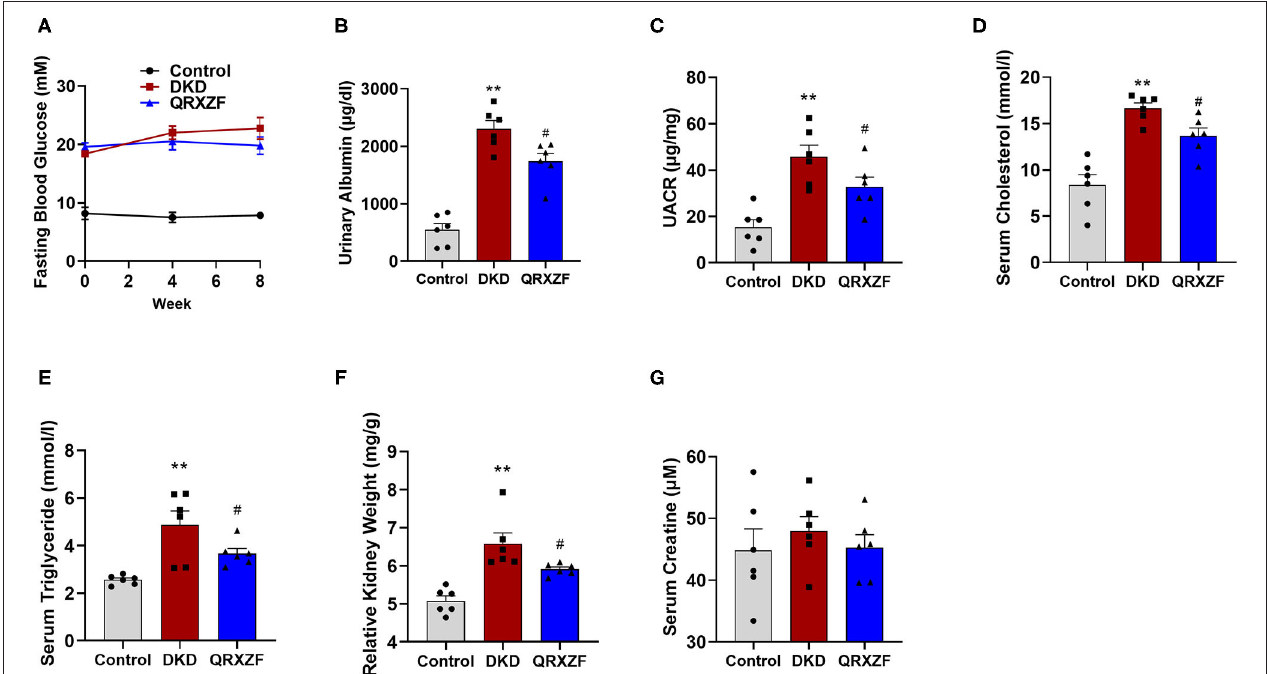
FIGURE 1 | QRXZF decreased urinary albumin and ameliorated disorder of lipid metabolism in DKD mice after 8 weeks ( n = 6, means ± SEM). (A) Serum glucose; (B) Urinary albumin content; (C) Urine albumin to creatinine ratio (UACR); (D) Serum cholesterol; (E) serum triglyceride; (F) Kidney weight/body weight; (G) Serum creatinine. * P < 0.05, ** P < 0.01 DKD group vs. the control group; # P < 0.05, ## P < 0.01 QRXZF group vs. the DKD